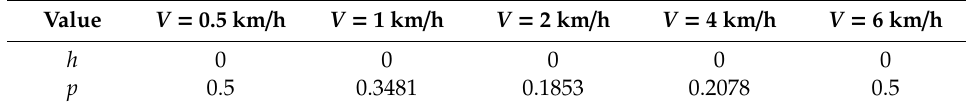
Table 5. Normal distribution test result of absolute error.